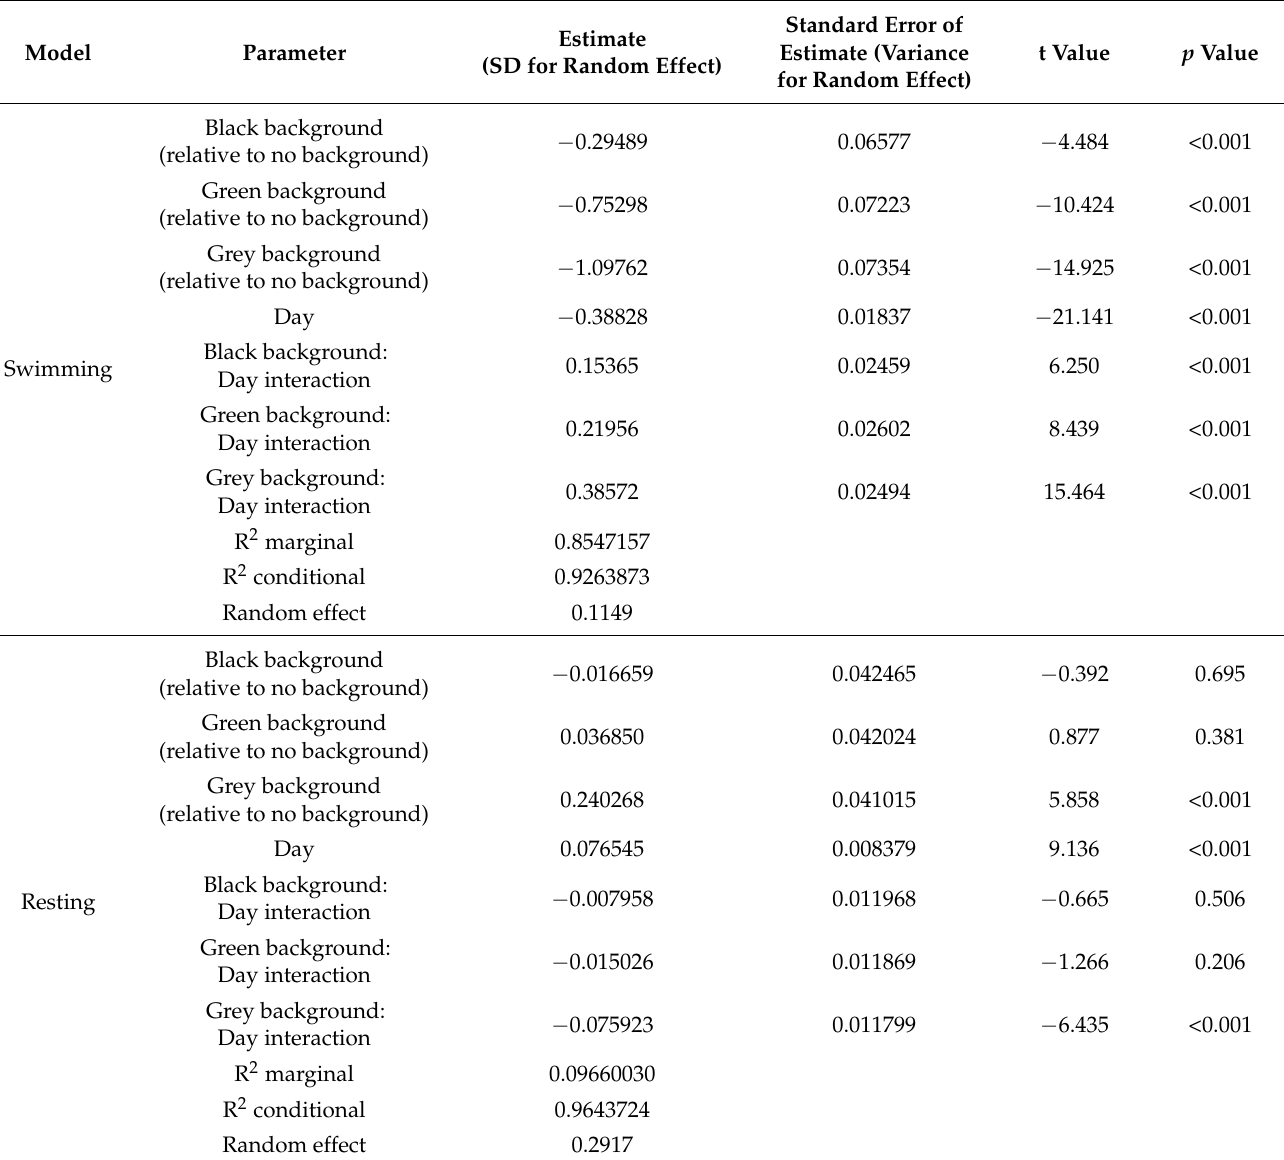
Table 3. Model summary table of generalized linear mixed models swimming and resting